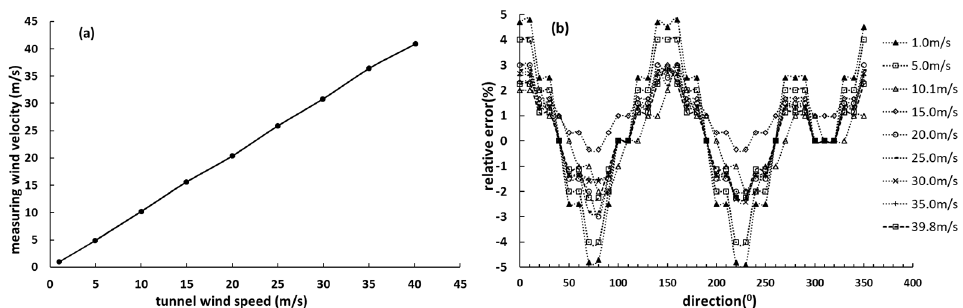
Figure 9. The wind speed test results, ( a ) linear wind speeds relationship and ( b ) the relative errors.